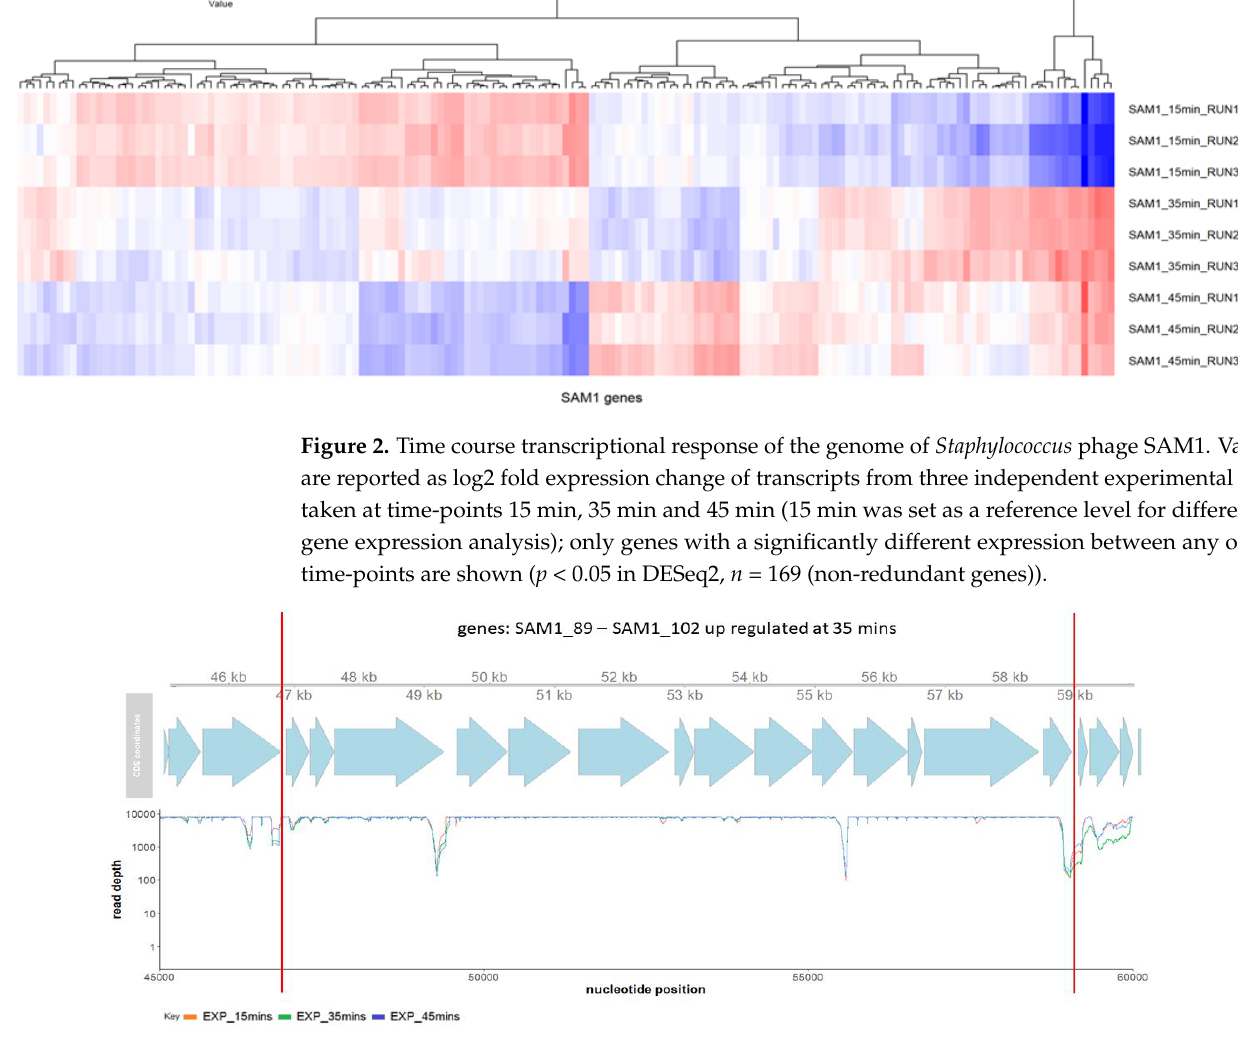
Figure 3. Comparison of RNA-Seq sequence depth with gene map (region spanning bases 45,000 to 60,000) of Staphylococcus phage SAM1. The gene map comprises of arrows representing genes, their length and location, with the direction of the arrow indicating direction transcription. It can be observed that areas of low sequence coverage often correlate with the gene cluster boundary (red lines) that are up regulated at similar time points during phage infection of the host.